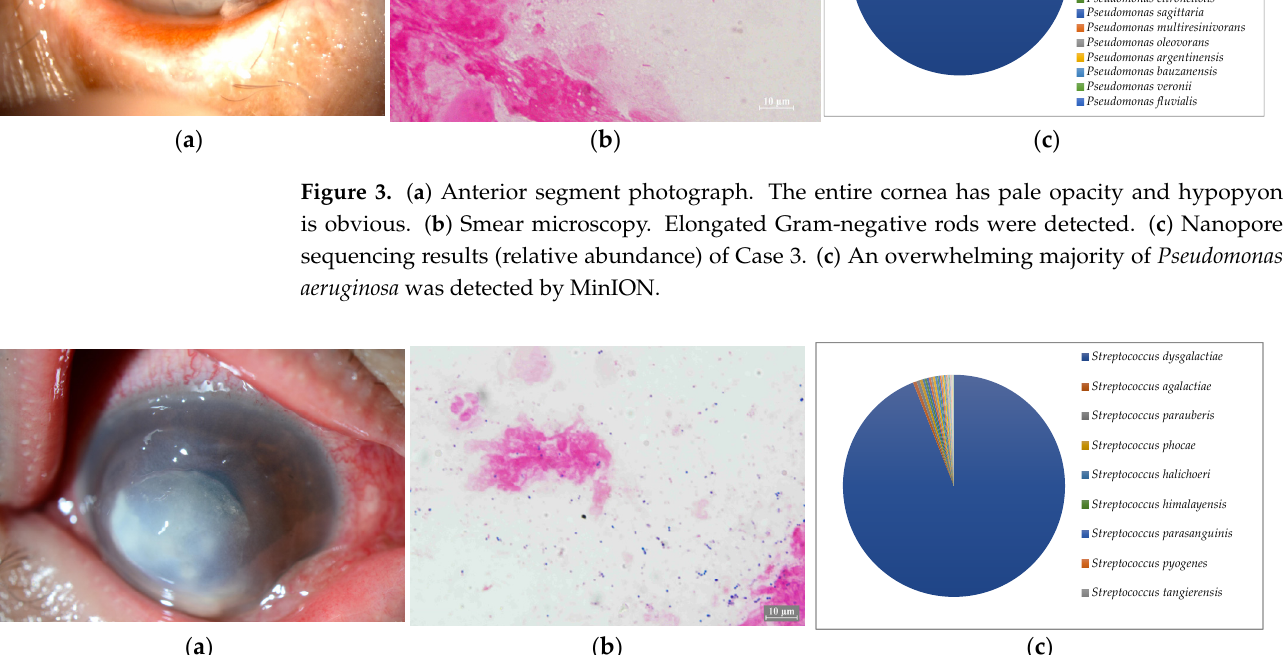
Figure 4. ( a ) Anterior segment photograph. The lower 3/4 of the flap created by former LASIK forms a circular abscess. ( b ) Smear microscopy. Gram-positive chain cocci were detected. ( c ) Nanopore sequencing results (relative abundance) of Case 4. An overwhelming majority of Streptococcus dysgalactoae was detected by MinION.